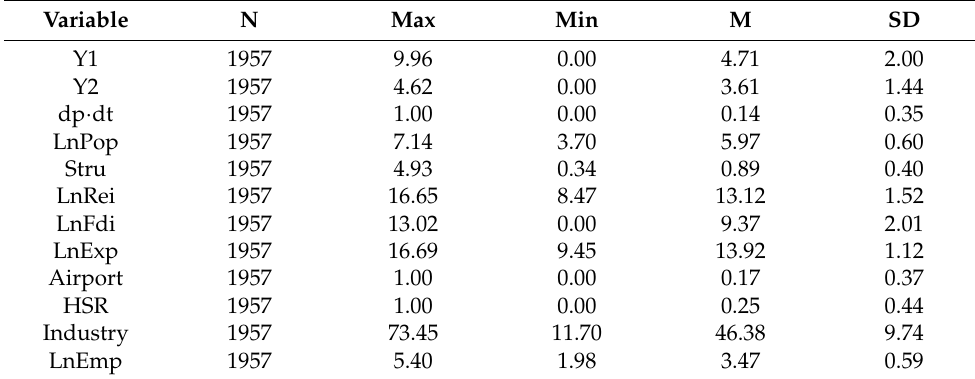
Table 2. The descriptive statistics of original